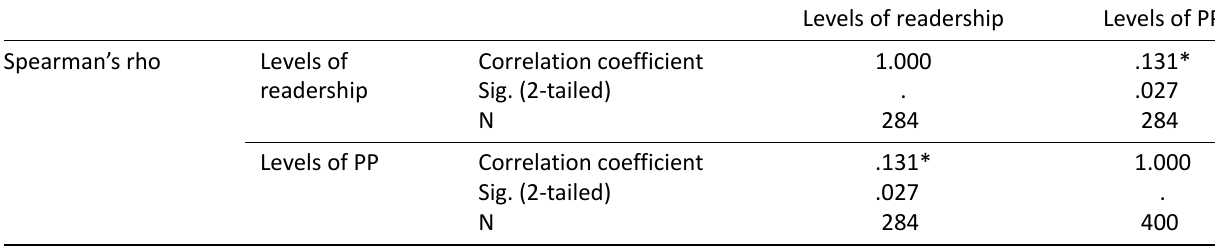
Levels of readership Levels of PP